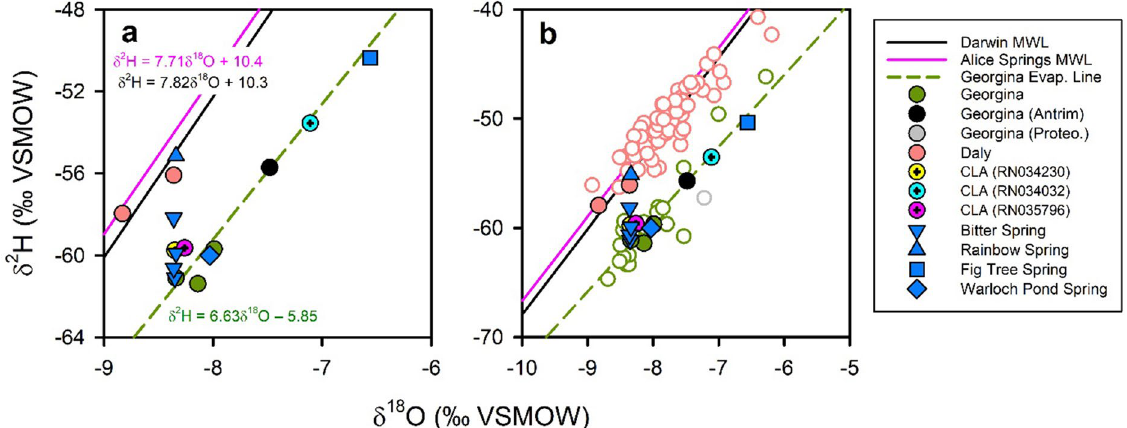
Figure 4. Stable isotopes of water. (a) Isotopic composition of springs and groundwater at the Mataranka Springs Complex, also showing the Darwin Meteoric Water Line 12 , Alice Spring Meteoric Water Line 12 and the evaporation line for Georgina flow path groundwater. (b) Regional trends in isotopic composition along the Daly and Georgina flow paths (open symbols) also including groundwater and spring samples from the complex (closed symbols).